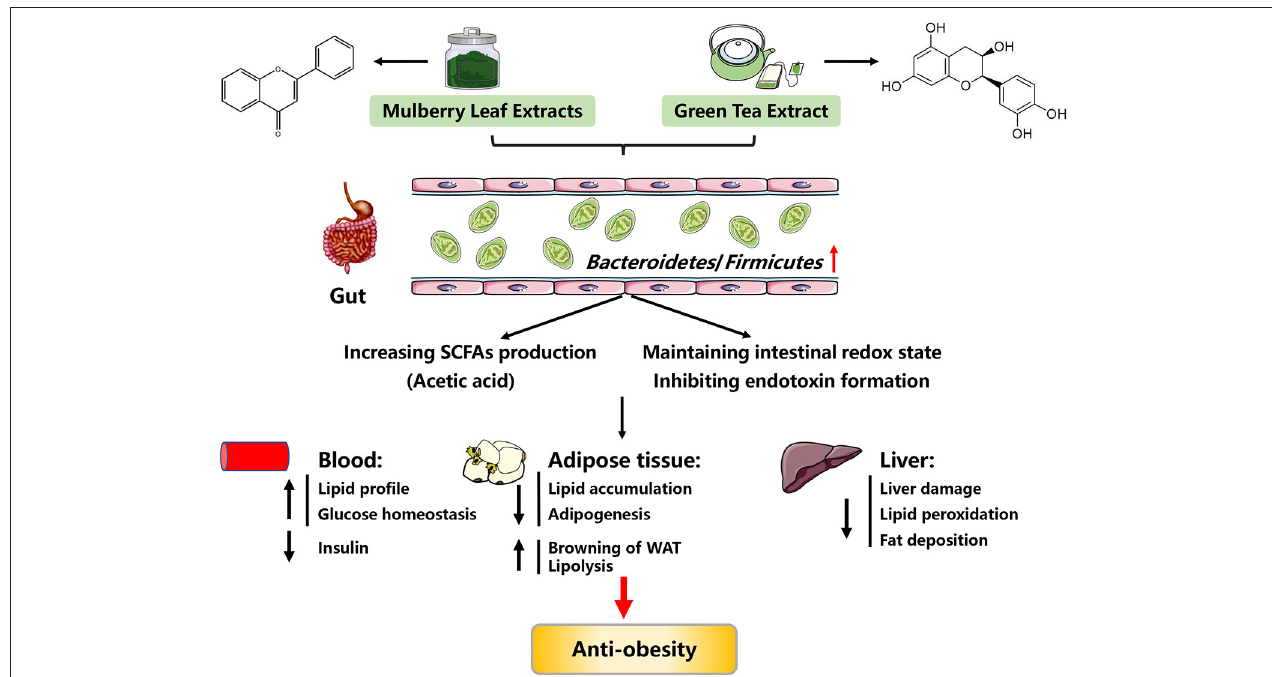
FIGURE 2 | Possible mechanisms explaining the anti-obesity effects of mulberry leaf extracts and green tea extracts. SCFAs, short chain fatty acids; WAT, white adipose tissue.